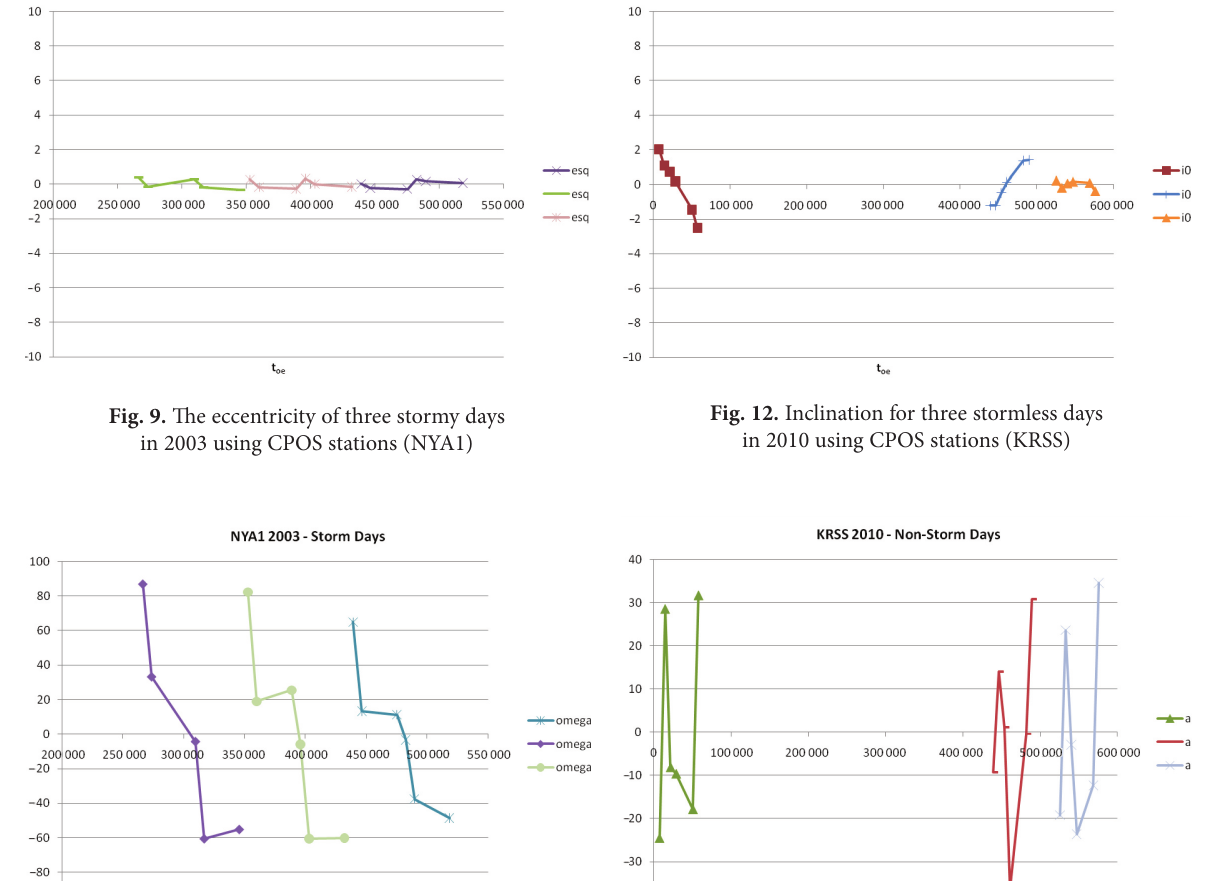
Fig. 13. a semi-major axis of three stormless days in 2010 using cPOS stations